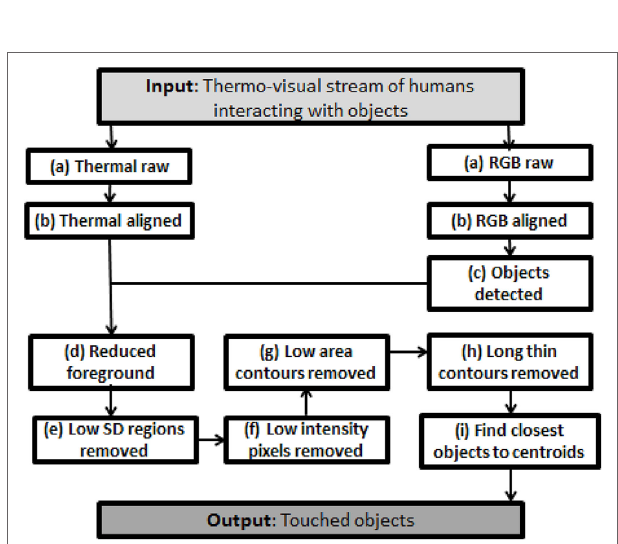
FigUre 2 | PastVision + : process flow.